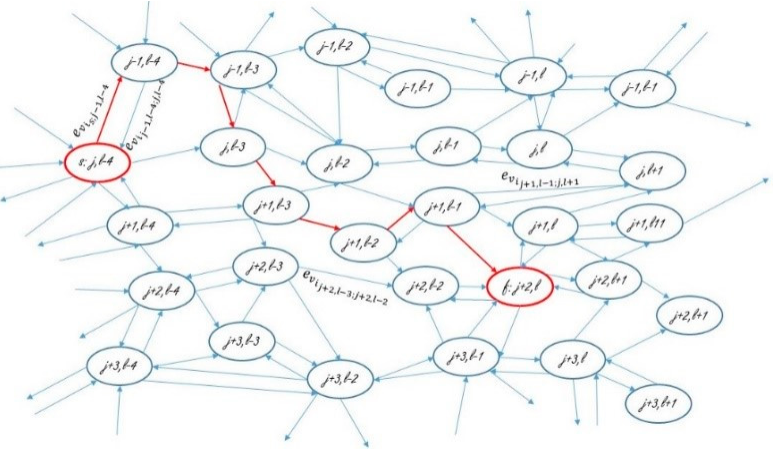
Figure 3. Graph model of a road system